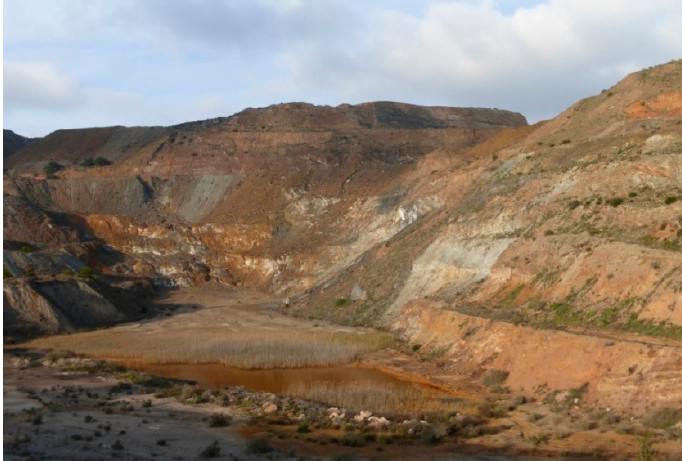
Figure 2. Specific quarry in the Cartagena-La Unión mining area. Municipality of Cartagena. Author: Carlos J. Pardo Abad.